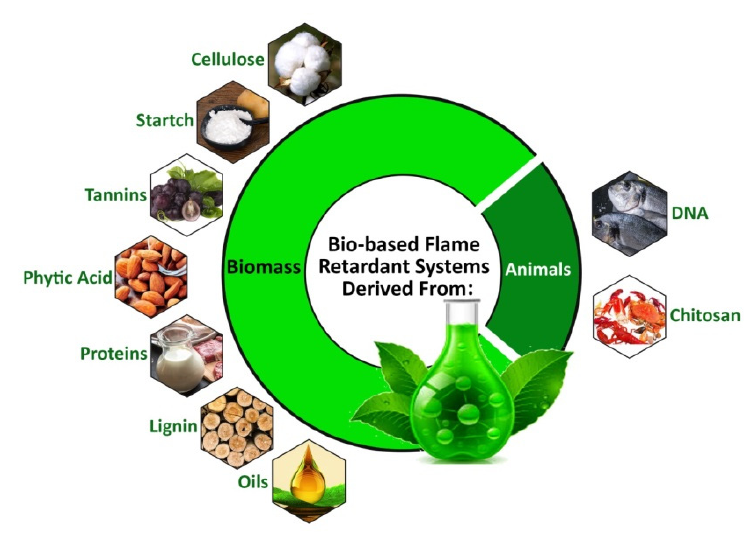
Figure 1. Schematic representation of bio-based flame retardant systems derived from animals (DNA and chitosan) and biomass (cellulose, starch, tannins, phytic acid, proteins, lignin, and oils) [6]. Reproduced/Adapted with permission from [6]. Copyright (2021, Elsevier).